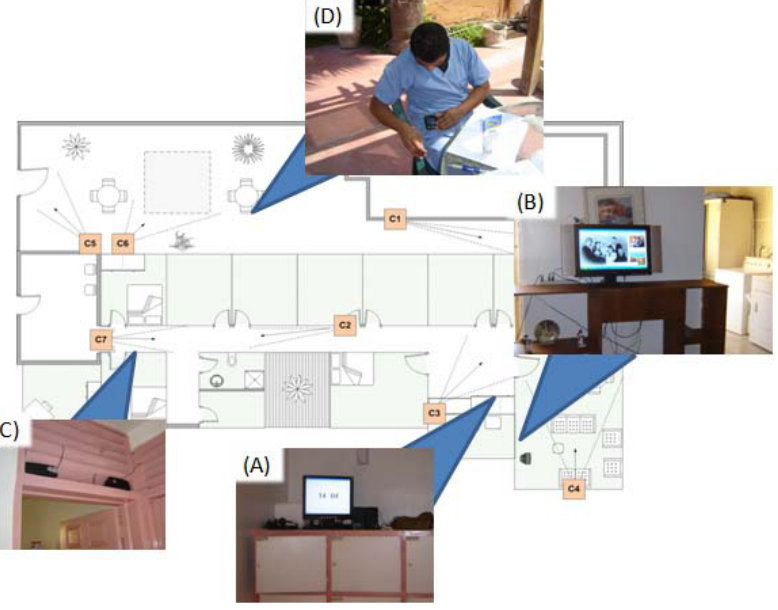
Figure 15. CANoE-Aw notification mechanisms installed at the nursing home: ( A ) ‘Wall Clock’ at the Nursing Area; ( B ) ’Digital Portrait’ at the Dinning-Living room; ( C ) ‘Ambient Audio’ at the Corridor; and ( D )‘Mobile Device’ carried out by each caregiver.